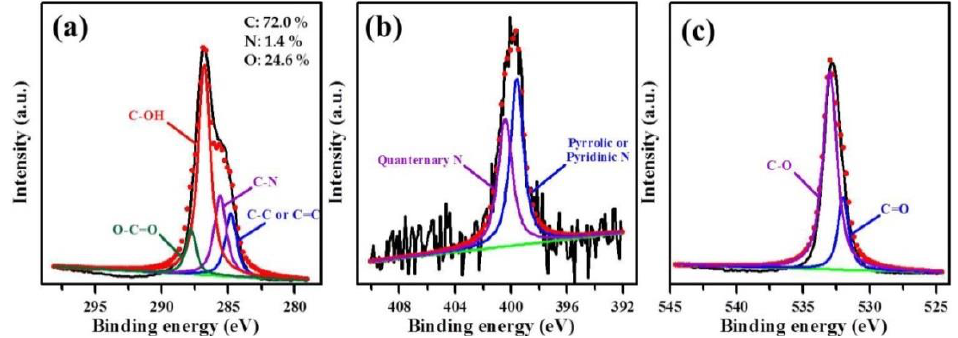
Figure 4. XPS spectra of PEG 6000 / CD sample: ( a ) O 1s peak, ( b ) N 1s peak and ( c ) O 1s peak, deconvoluted by a multiple Gaussian